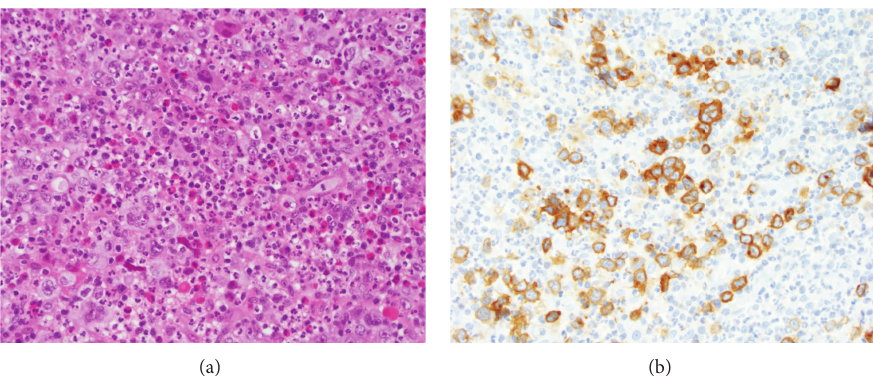
Figure 2: Pathology microscopy of excisional biopsy of a right cervical lymph node (a) showed effacement of the lymph node architecture by a mixed infiltrate of neutrophils, eosinophils, histiocytes, and small lymphocytes, with scattered Reed-Sternberg cells (H&E stain 40x). (b) Immunohistochemical staining for CD30 highlighted the Reed-Sternberg cells